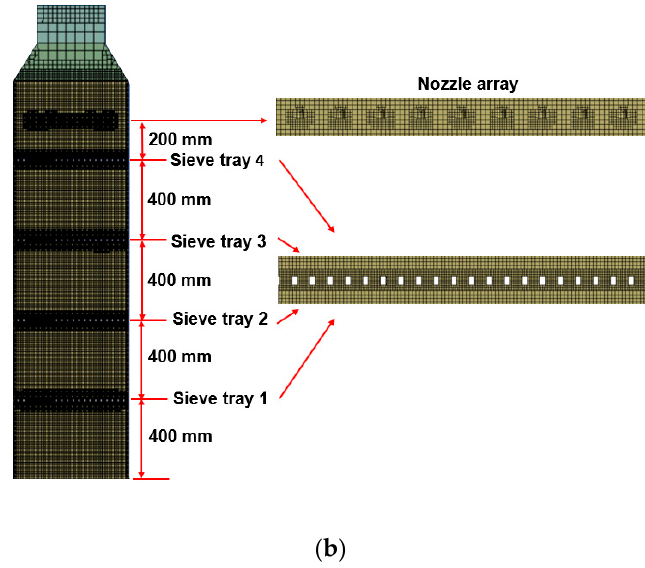
Figure 6. The figure displays the grid distributions of the small-scale FGD tower at the symmetric plane (z = 0) in ( a ) and the detailed layouts for the right tower near the sieve trays and nozzles in ( b